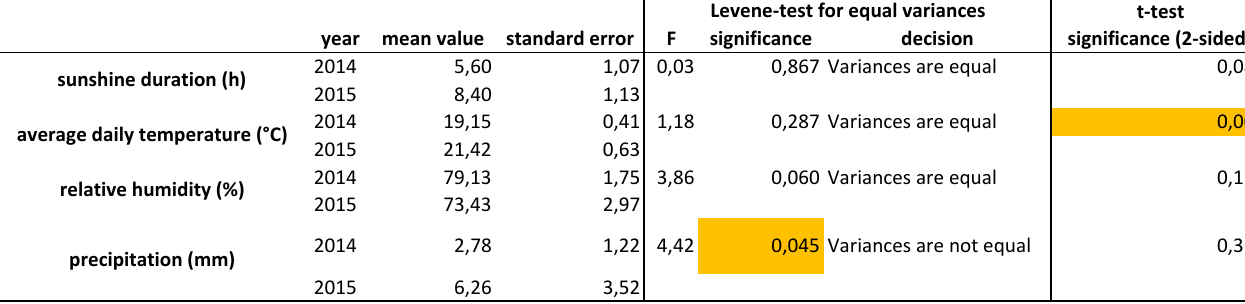
Table S9: t-test between the years 2014 and 2015 of the climate variables sunshine, temperature, relative humidity, and precipitation calculated as mean values for the period May until